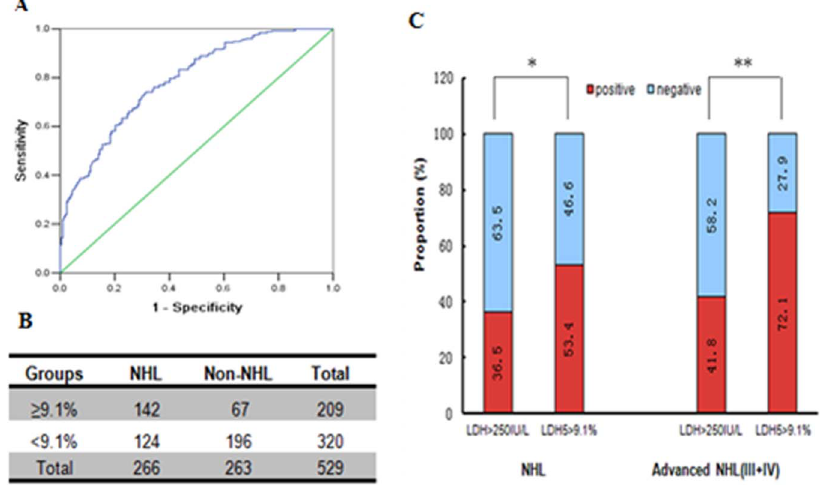
Figure 2. Comparison of LDH-5 and total LDH levels in NHL patient serum. (A) ROC analysis of LDH-5 showed that the cutoff value set at 9.1% gives the best diagnostic efficiency (AUC=0.788, n=529). (B) The sensitivity and specificity for NHL diagnosis were 53.4% (142/266) and 74.6% (196/263) at the LDH-5 cutoff value (9.1%), respectively. (C) Serum LDH-5 concentration $ 9.1% has more positive results than total LDH $ 250 IU/L in all NHL patients (n=266) and patients with advanced NHL (III + IV, n=122). * P , 0.05; ** P , 0.01.